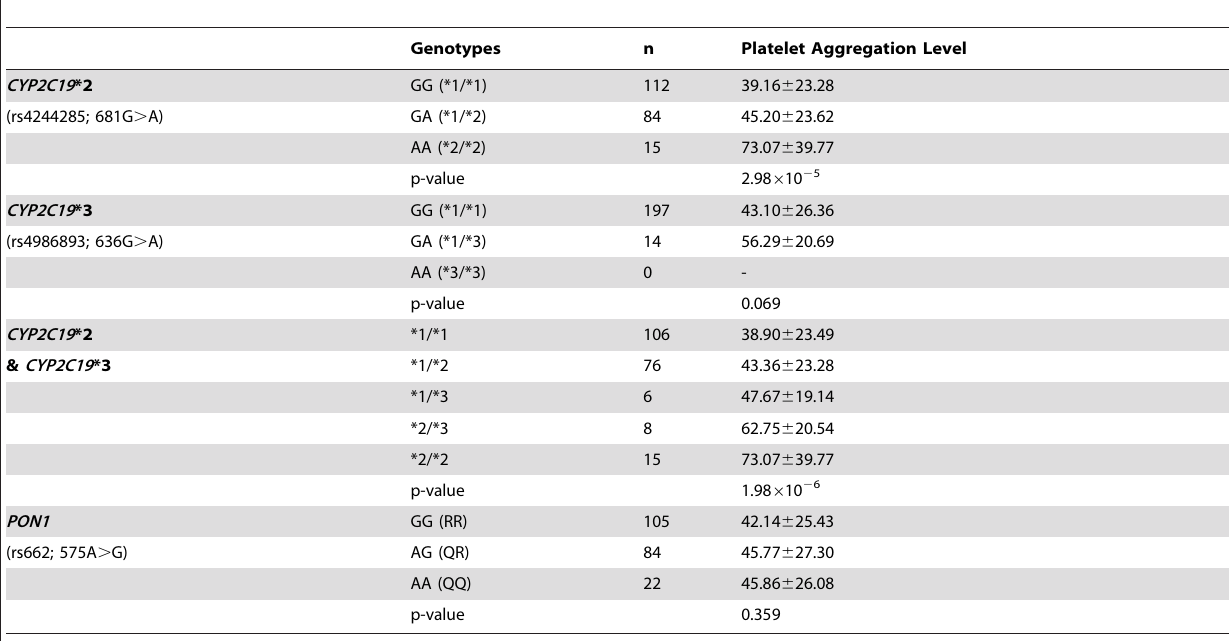
Table 5. ADP induced platelet aggregation level by CYP2C19*2, *3 and PON1 Q192R polymorphisms in clopidogrel treated patients with coronary artery